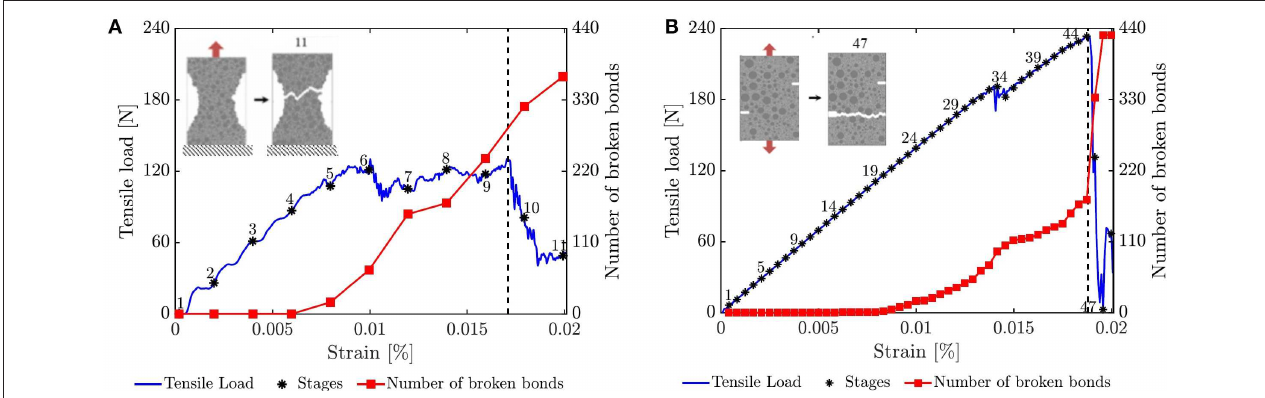
FIGURE 2 | (Color online) Global response. Evolution with strain of the macroscopic tensile load and the total number of broken bonds in the specimen for (A) DI, (B) DII. Dashed vertical line marks the stage at peak